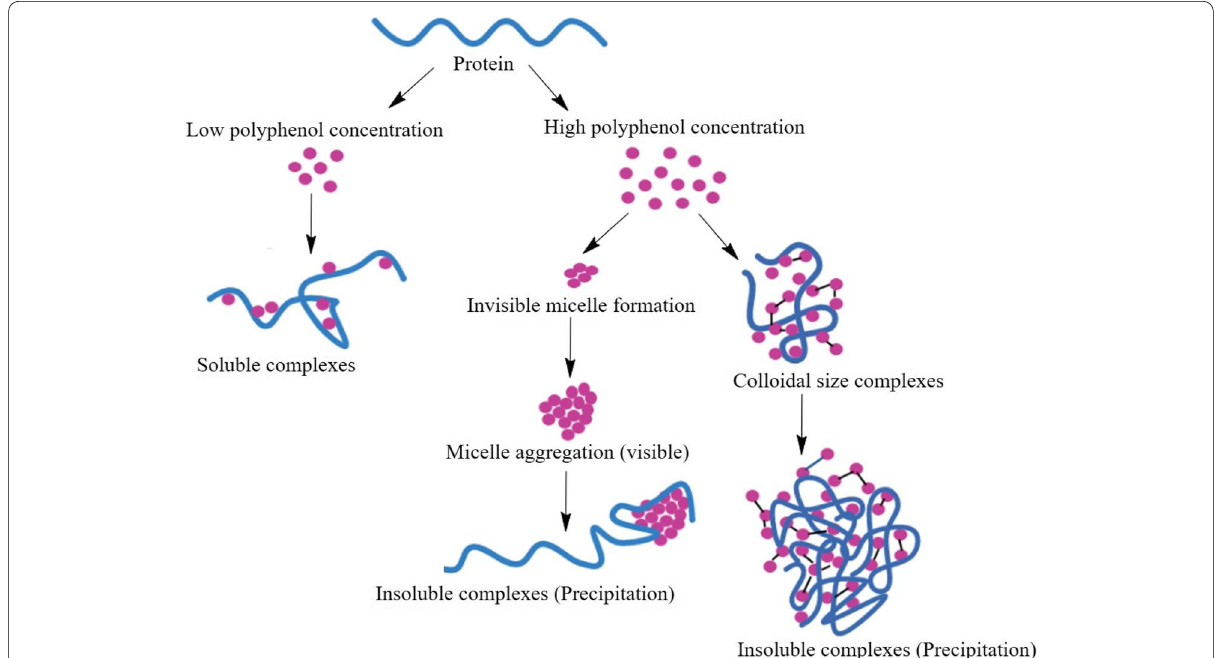
Fig. 8 Schematic representation of possible polyphenolic-protein interaction mechanism (Adapted from Canon et al. 2011; Charlton et al.